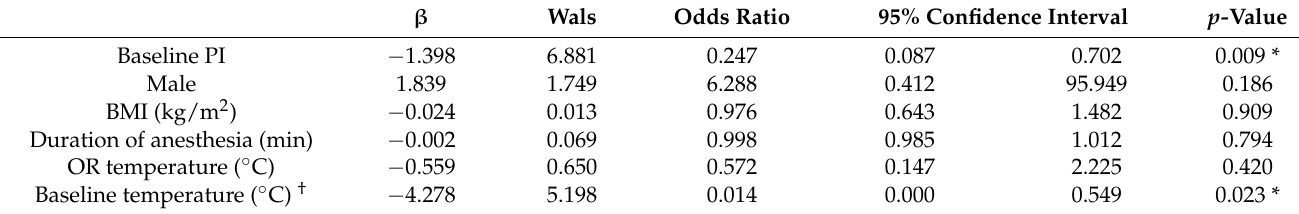
Table 3. Multivariate logistic regression analysis of intraoperative